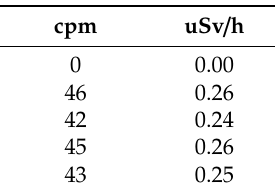
Table 1. Output of radiation dose in uSv/h and counts per minute.